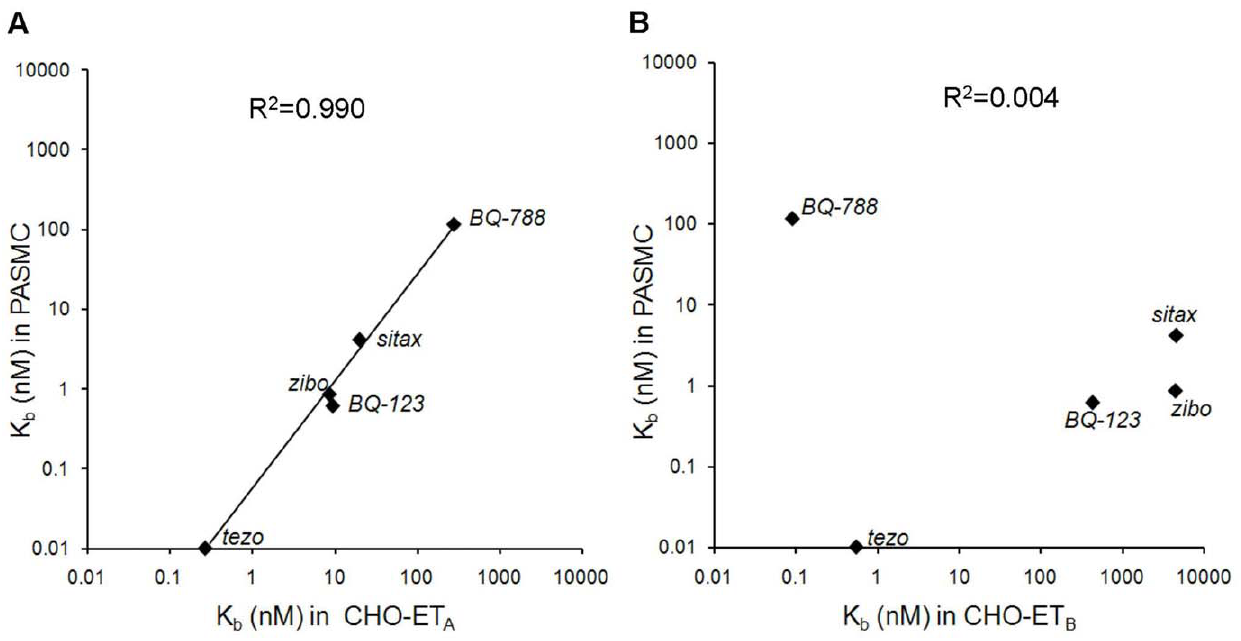
Figure 1. Contribution of endothelin receptor subtypes to calcium signaling in human primary PASMC. PASMC or CHO-ET A or CHO-ET B cells were pre-incubated with reference ERA dilution series for 120 min and then stimulated in the FLIPR with ET-1 (EC 50 –EC 70 ). IC 50 values were calculated from fluorescence peak responses and transformed into K b values as described in Methods. Correlation scatter plot of K b values obtained in PASMC versus CHO-ET A cells (A) or versus CHO-ET B cells (B). The correlation line and R 2 value was generated by linear regression of the double- logarithmic data. Geometric means of n=3–8 determinations are shown.